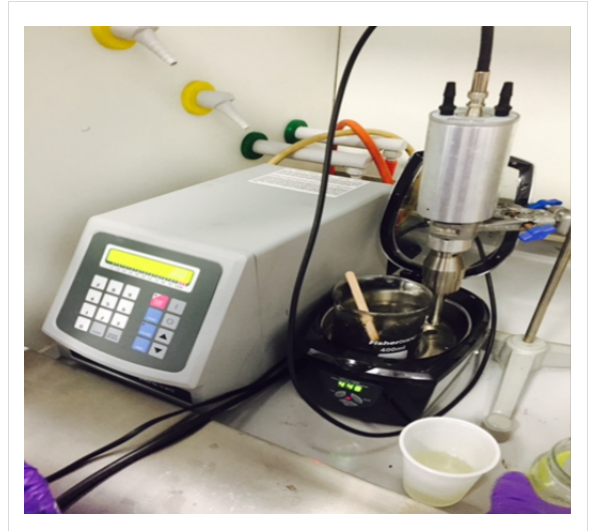
Figure 5: A combination of bath sonication, tip sonication, and manual stirring can help to improve the dispersion of filler in a polymer